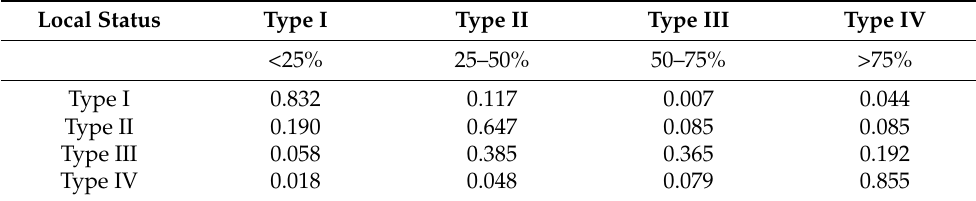
Table 3. Traditional Markov chain probability transition matrix of the CLUE in the study area from 2008 to